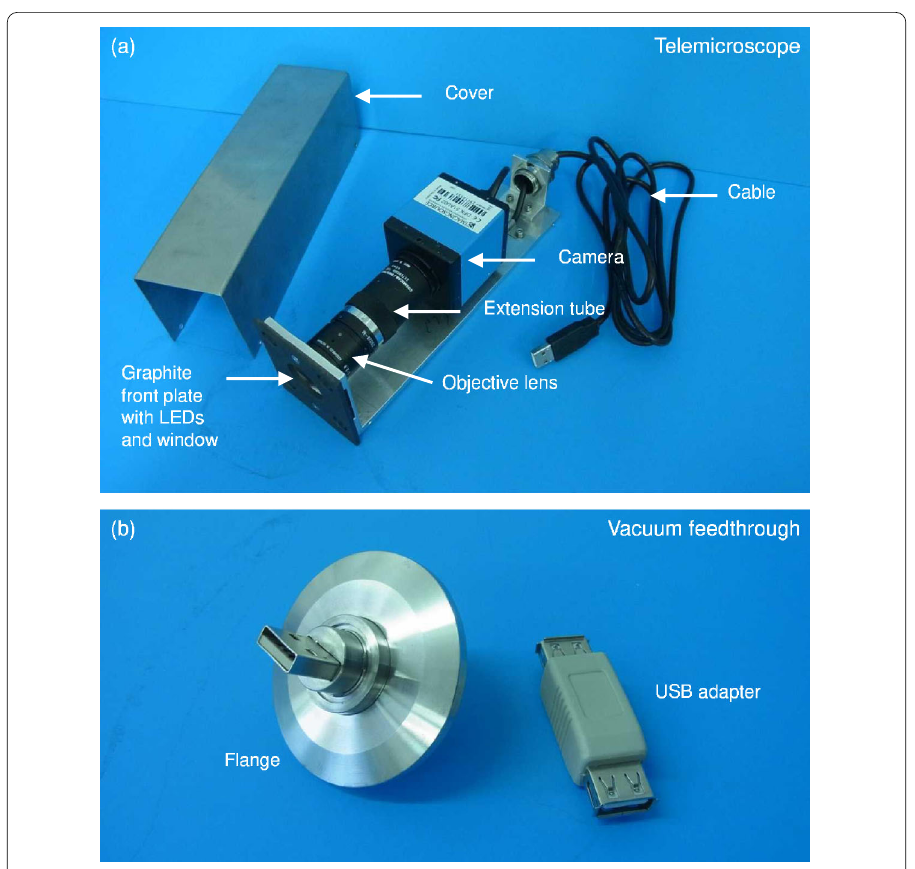
Figure 8 Experimental setup for insitu telemicroscope measurements: telemicroscope with housing ( a ) and vacuum feedthrough with adapter ( b )